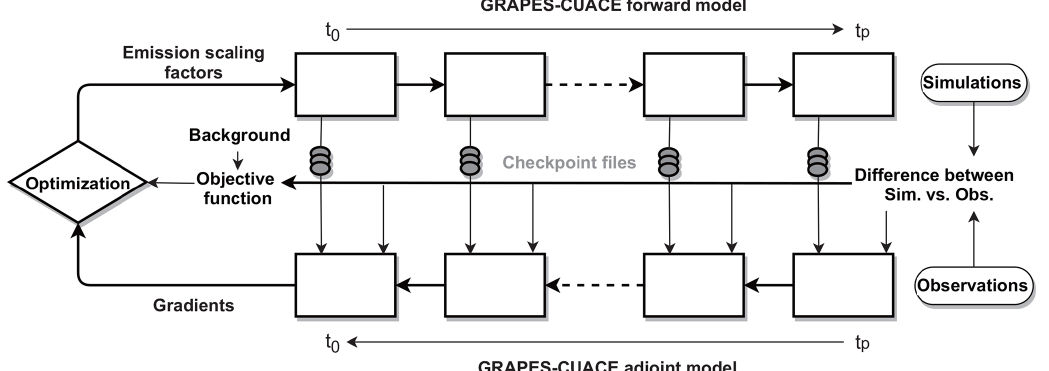
Figure 2. GRAPES–CUACE-4D-Var assimilation